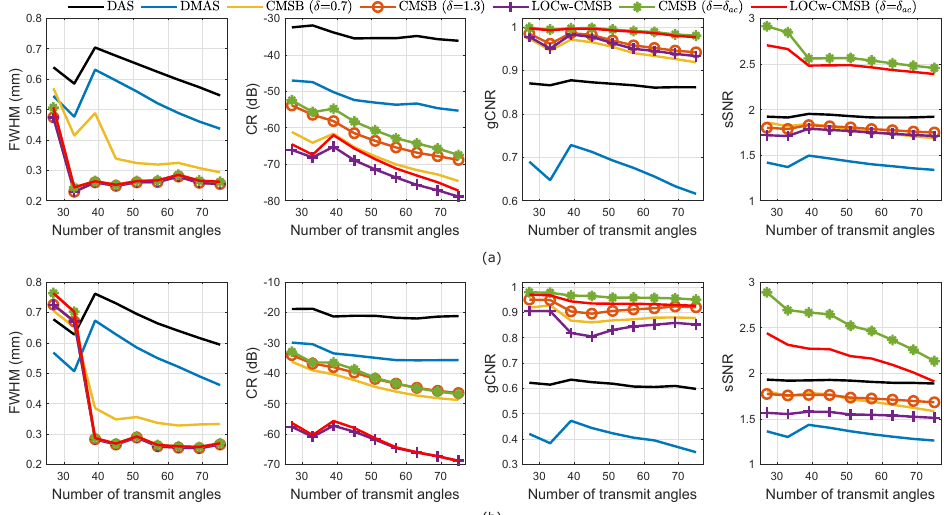
Figure 11. Image quality metrics of different methods as a function of the number of transmit angles in ( a ) simulation, and ( b )